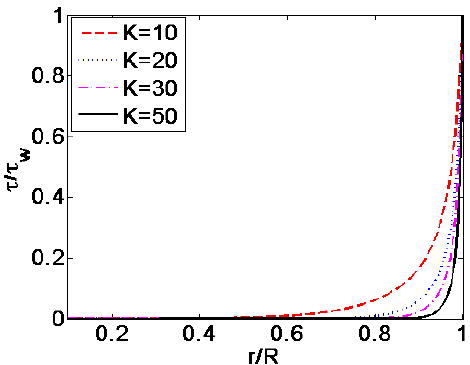
Figure 7. The corresponding changes of dimensionless shear stress distribution generalized with the magnitude of shear stress at the channel wall τ w for various width ratio K ( ξ = − 4).